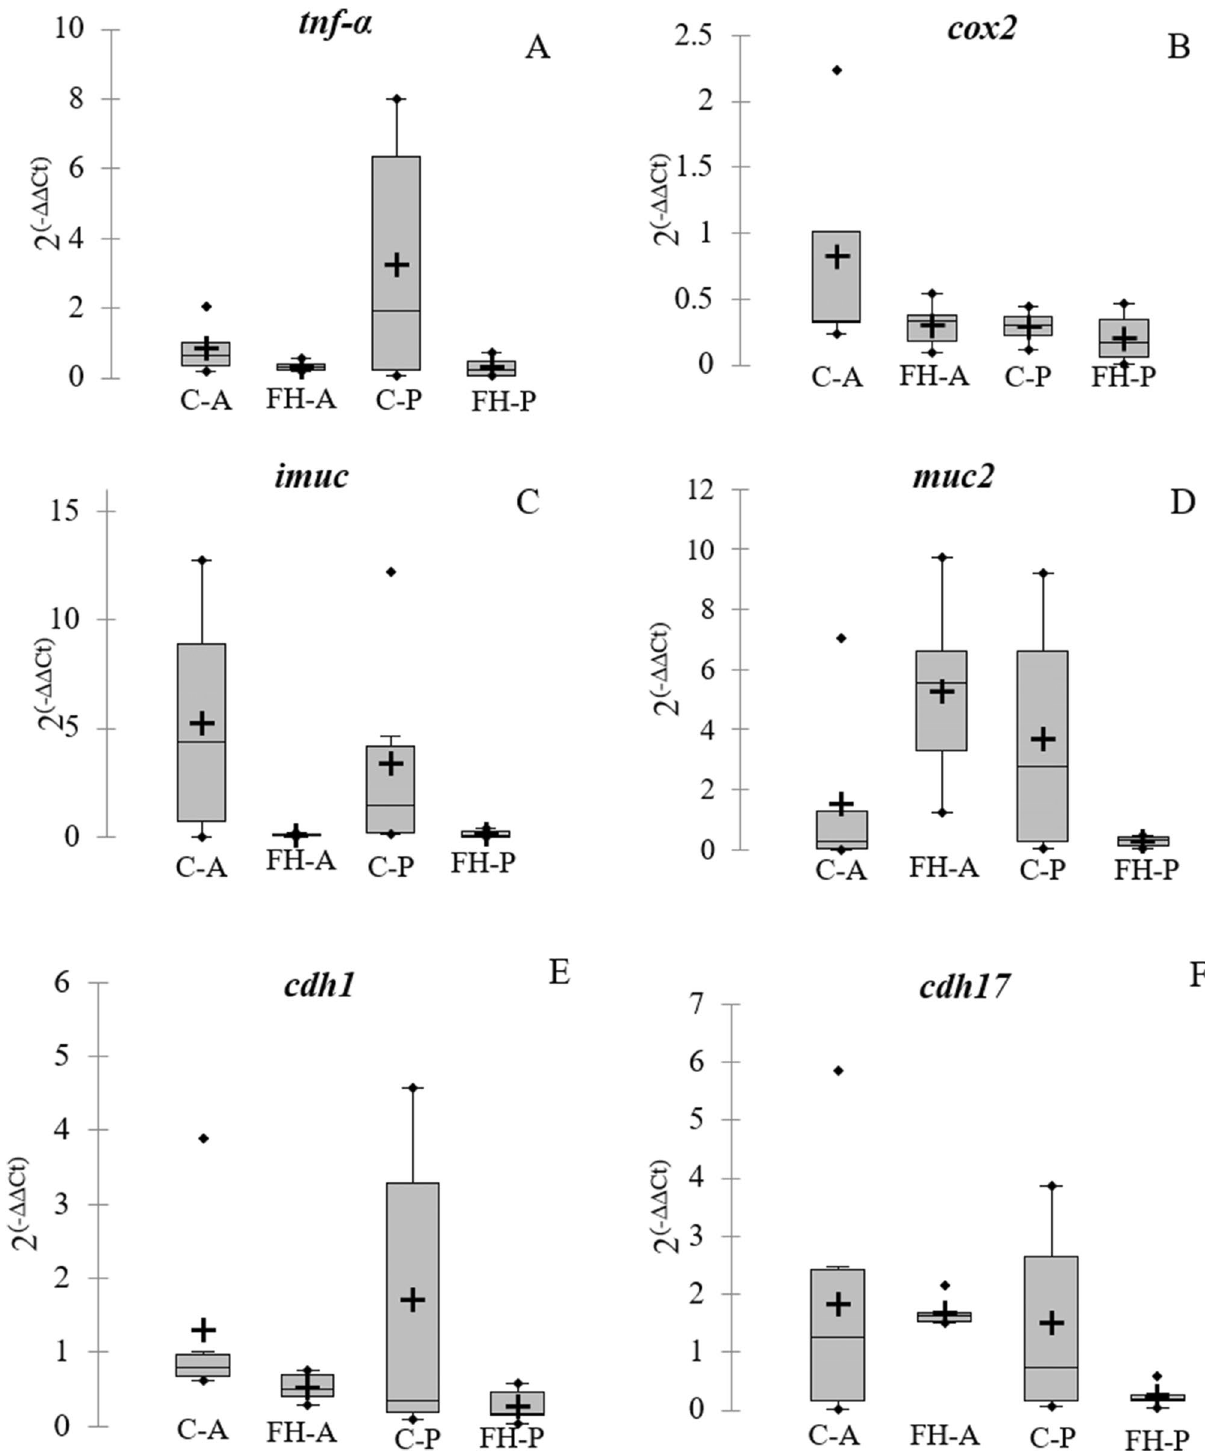
Figure 7. Boxplots for relative gene expression in the intestine of gilthead seabream fed with the experimental diet (FH) and the control group (C). ( A ) necrosis tumoral factor α ( tnf-α ); ( B ) cycloogygenase 2 ( cox2 ); ( C ) intestine mucin ( imuc ); ( D ) mucin 2 ( muc2 ); ( E ) cadherin 1 ( cdh1 ); ( F ) cadherin 17 ( cdh17 ); ( G ) claudin 12 ( cldn12 ); ( H ) claudin 15 ( cldn15 ); ( I ) zona-occludens 1 ( zo1 ); ( J ) ocludin ( ocln ); ( K ) vimentin ( vim ); ( L ) integrin 6-β ( itgb6 ); ( M ) tubulin ( tub ) and N , peptide transporter 1 ( pept1 ). Bars represent relative gene expression (mean + standard error) for each group, in the intestinal anterior section (A) and the posterior section (P). The crosses correspond to the means and the horizontal bars to the median. Points above or below the upper and lower limits are considered outliers. Differences between experimental groups in each section were considered at p <